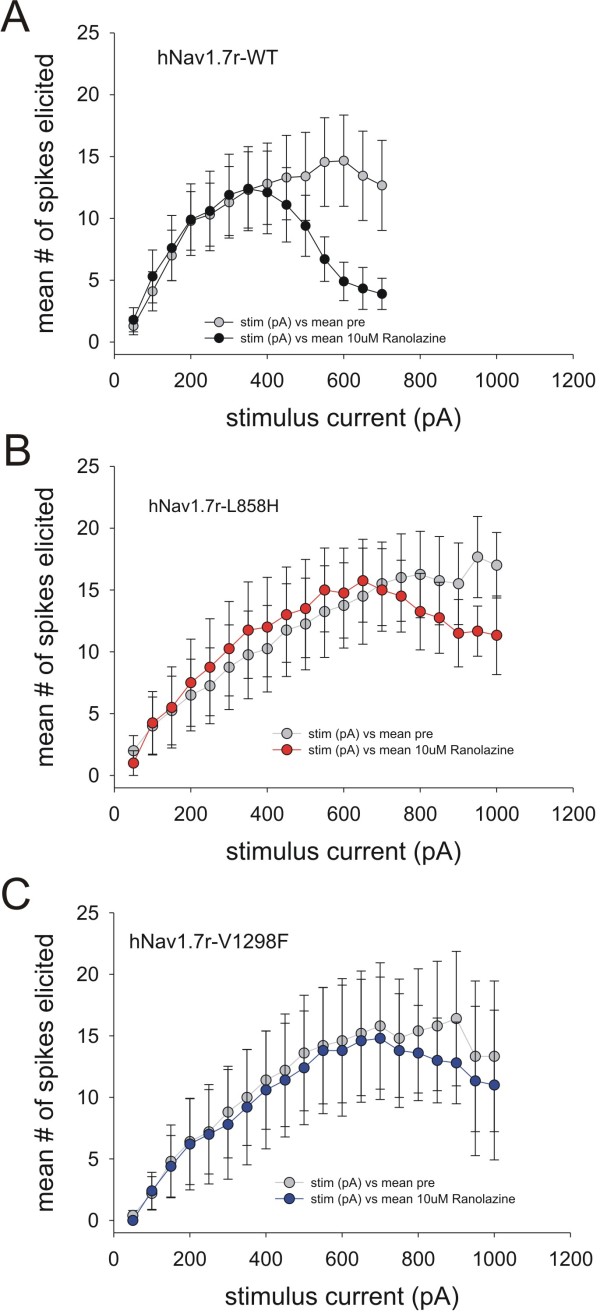
Effect of ranolazine on the excitability of DRG neurons expressing WT, L858H or V1298F channels. Action potentials were recorded in current-clamp mode from DRG neurons transfected with WT (panel A), the IEM mutant L858H (panel B), or the PEPD mutant V1298F (panel C), channels as described in the Methods section. The number of action potentials elicited during current injections of 1-sec duration ranging from 50 pA to 1000 pA in 50 pA increments are counted both before and then again after exposure to 10 μM ranolazine. In this figure, cells whose response did not exceed 5 spikes were removed to compare just the high firing cells. The average number of action potentials elicited at each current injection level are plotted before (grey) and after 10 μM ranolazine (solid) exposure. In each panel the two datasets are shown to compare the response to ranolazine in cells expressing WT (panel A, n = 10), the IEM mutant L858H (panel B, n = 4), or the PEPD mutant V1298F (panel C, n = 5), channels.